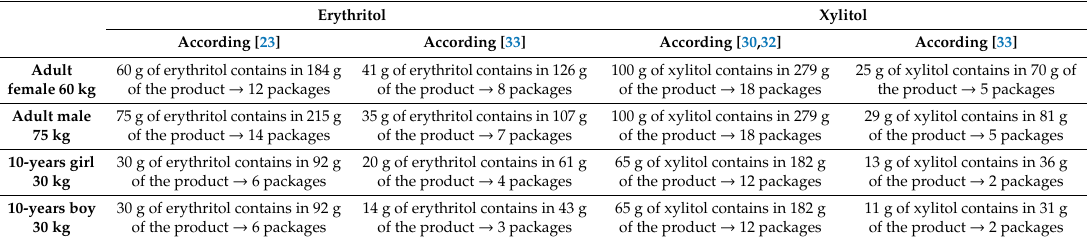
Table 5. Summary of product safety calculations containing the following polyols. Erythritol